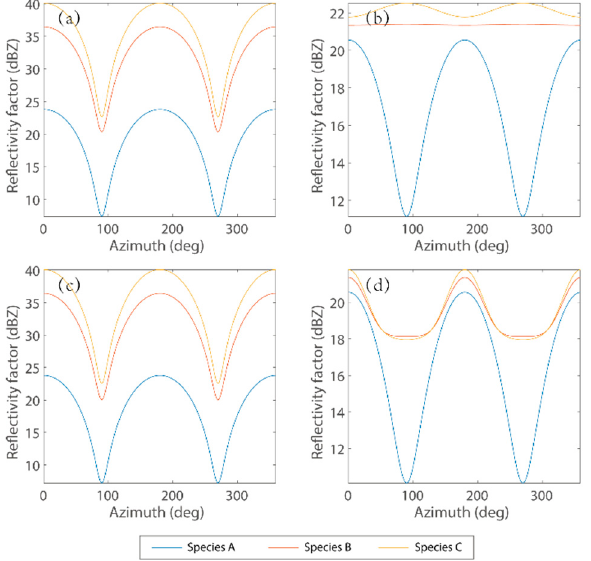
Figure 2. Azimuthal dependencies of the reflectivity factor for three species at the S-band ( a , c ) and X-band ( b , d ). As in ( a , b ), the elevation of the radar beam is 0.5 ◦ , which is the minimum elevation of VCP 21, and in ( c , d ), the elevation is 19.5 ◦ , which is the maximum elevation of VCP